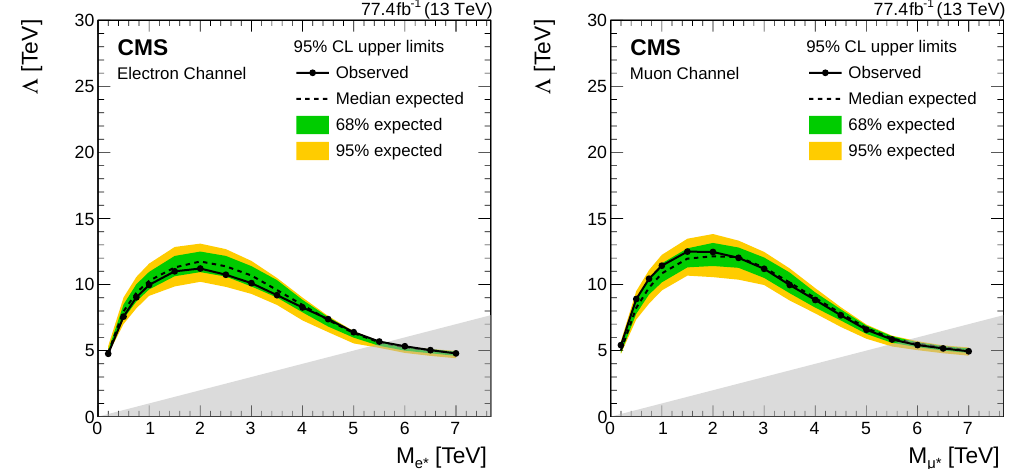
Figure 9 . Limits on the compositeness scale (cid:3) for the electron (left) and muon (right) channels, as a function of the mass of the excited lepton, for the benchmark case where the GI couplings and f 0 are set to one. The model is not valid in the hatched j j